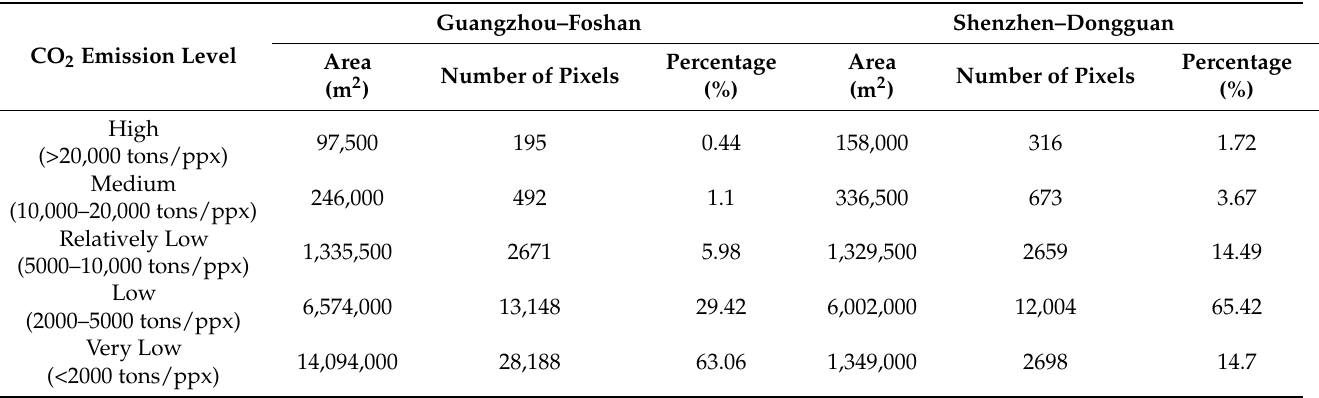
Table 4. Proportion of different levels of CO 2 emissions in the Guangzhou–Foshan and Shenzhen– Dongguan